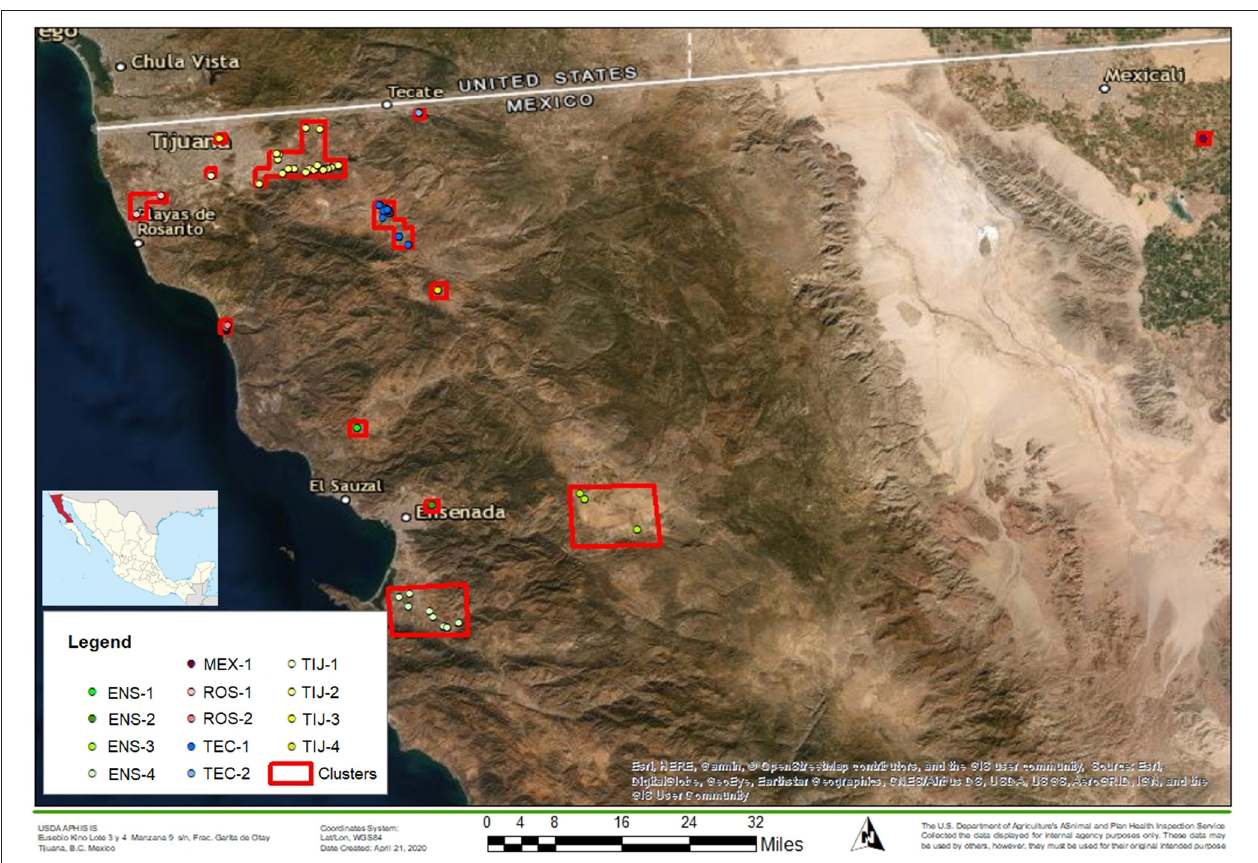
FIGURE 1 | Map of the northern region of Baja California. The location of BCA with respect to Mexico is shown on the left. Red squares represent dairy clusters ( n = 13) formed based on a maximum distance of 5km (radius) between dairies. Clusters’ names are indicated in the legend. The map was built using ArcGIS software (basemap